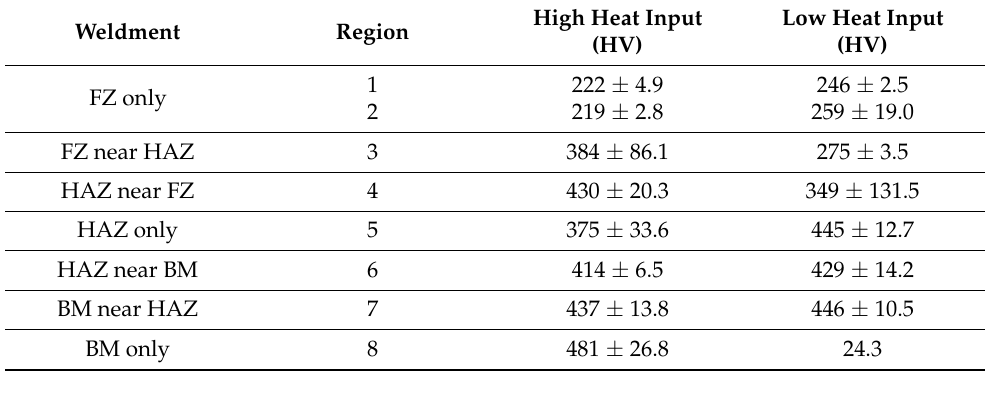
Table 2. Microhardness at weldment regions, according to Figure 8.